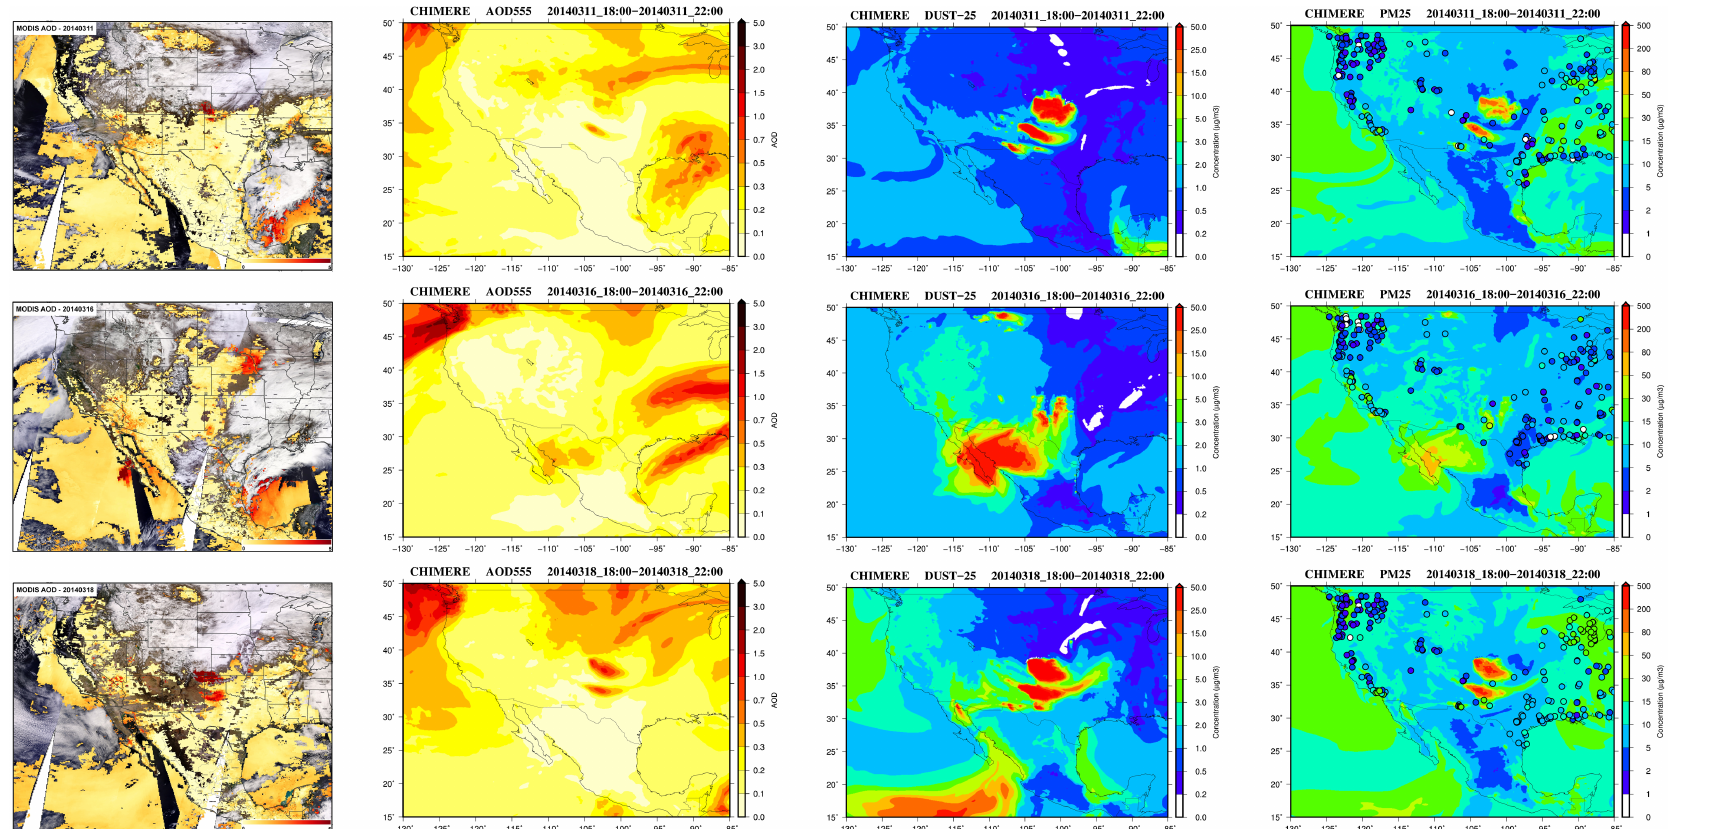
Figure 12. MODIS AOD 555 nm (Merged DT/DB Aerosol Optical Depth Land and Ocean product) on the left column compared to CHIMERE AOD (second column) for the same period of the satellite passes (average values from 18:00 to 22:00 UTC on 11, 16 and 18 March from the top to bottom to fit with the satellite ascending and descending passes). Dust concentrations in the fine fraction of particles and PM 2.5 concentrations for the same periods are, respectively, displayed in Column 3 and 4. The circles represent the ground observational data for PM 2.5